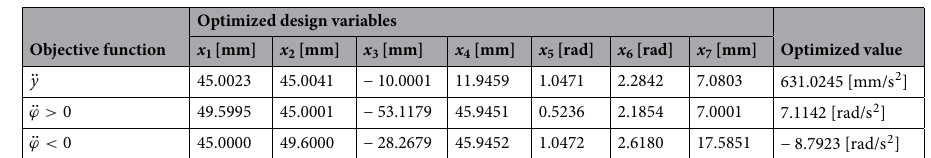
Table 4. The three optimized sets for each degree of freedom. Each optimized value is used for the normalization of performance score for the optimization.